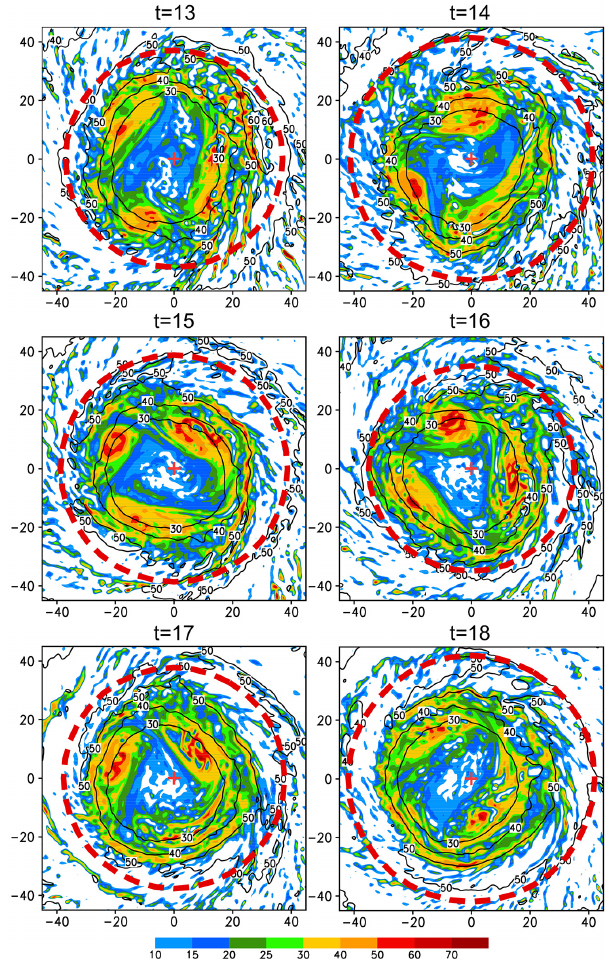
Figure 13. Distribution of potential vorticity (shaded, 10 − 6 m 2 s − 1 Kkg − 1 ) and magnitude of wind (contour, ms − 1 ) within the inner-core region during the period of 13–18h at 700hPa. The dashed circle shows the radius of maximum wind, with the tropical cyclone center indicating with crosses.